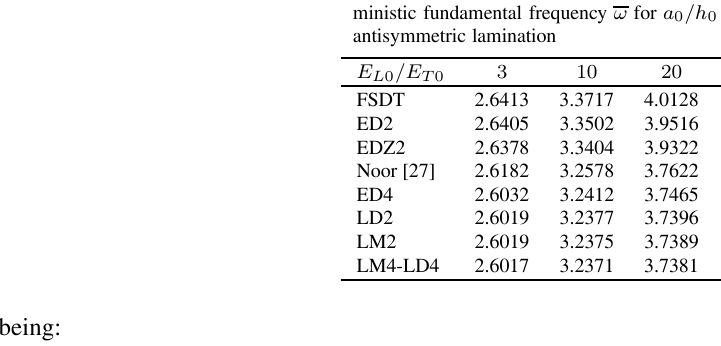
Table 1 Assessment of CUF models: fi rst dimensionless deter- ministic fundamental frequency ω for a 0 /h 0 = 5